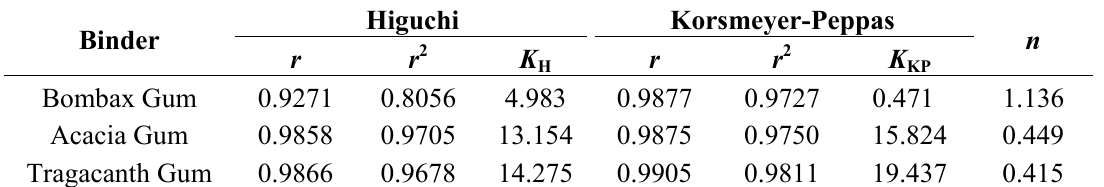
Table 4. Outcomes of mathematical modeling of drug release